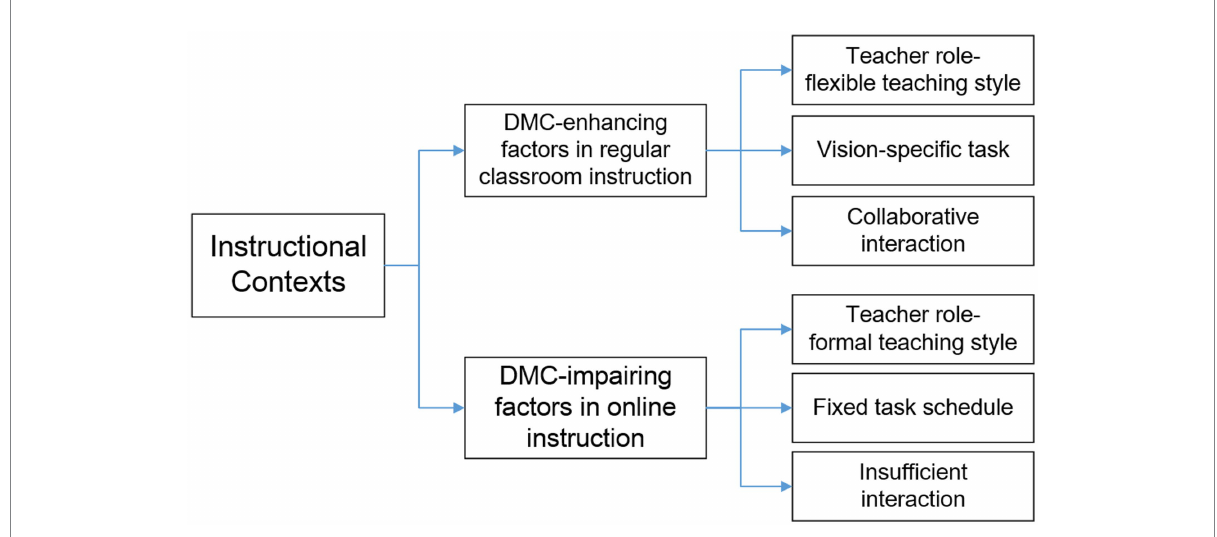
FIGURE 3 Directed Motivational Current (DMC)-influencing factors under different instructional